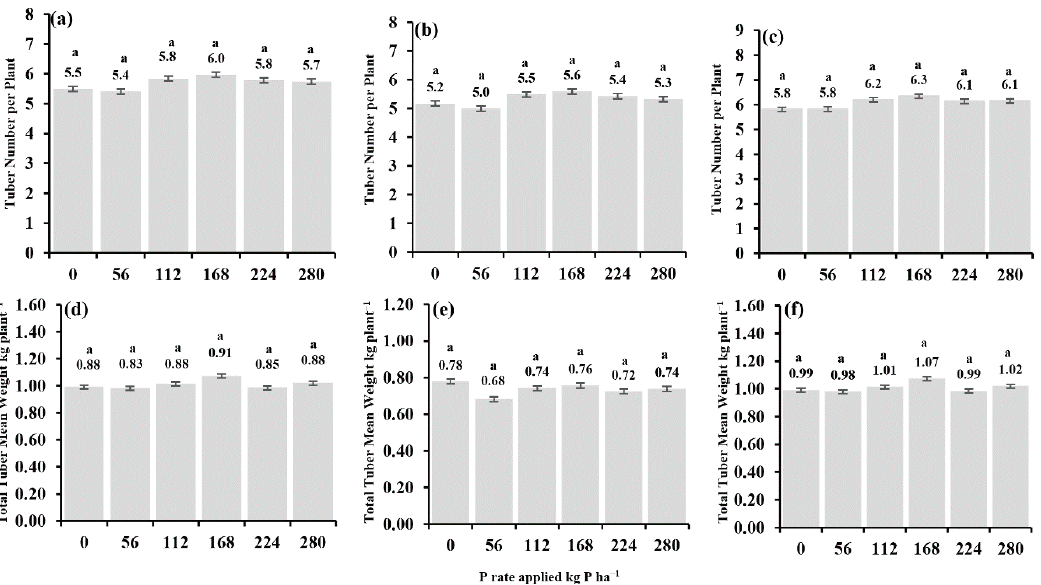
Figure 5. Effect of P rates on tuber number per plant at all sites combined( a ), all sites combined at soil pH ≥ 6 ( b ), all sites at soil pH < 6 ( c ), tuber mean weight at all sites combined( d ), all sites combined at soil pH ≥ 6 ( e ), all sites at soil pH < 6 ( f ). Means connected by the same letter are not significantly different (Tuckey’s test P < 0.05).